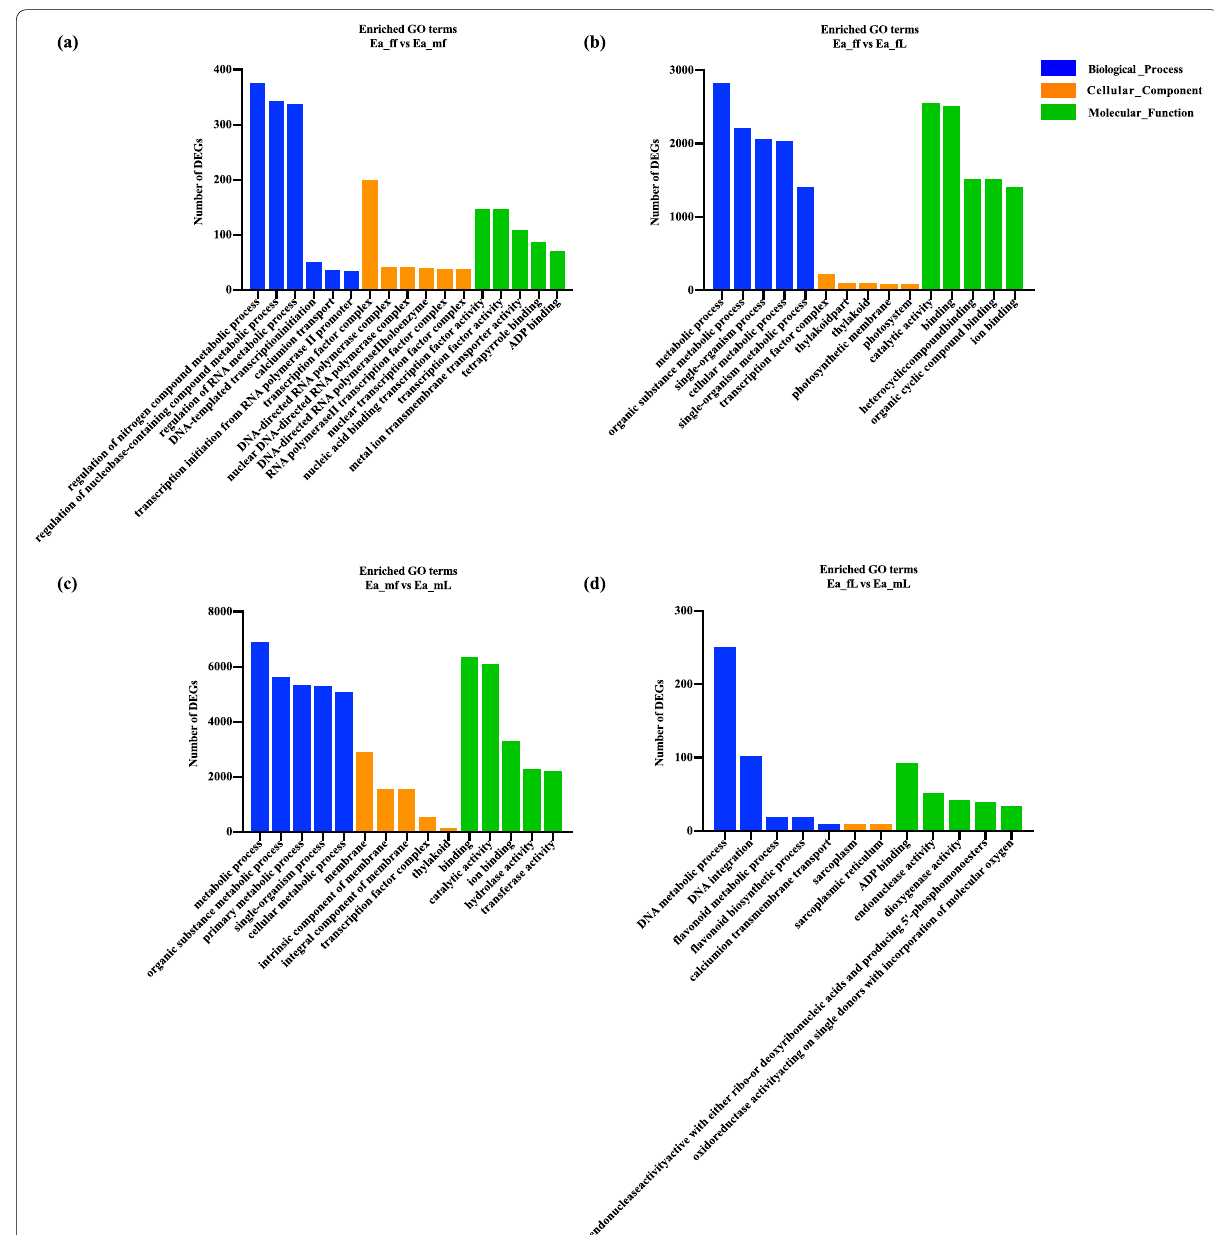
Fig. 3 GO functional enrichment map of differentially gene expression between female and male of E.agallocha in different comparison groups. a Ea_ff vs Ea_mf group. b Ea_ff vs Ea_fLgroup. c Ea_mf vs Ea_mL group. d Ea_fL vs Ea_mL